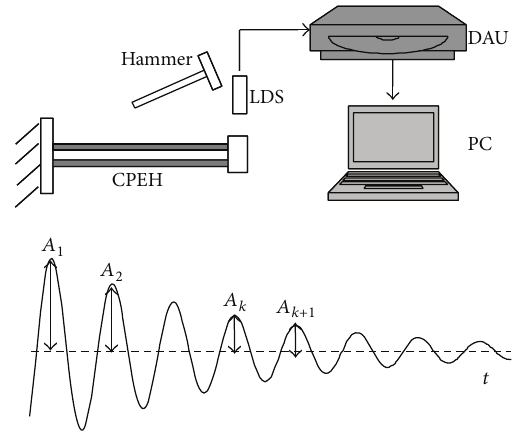
Figure 3: Test of damping factor of CPEH.